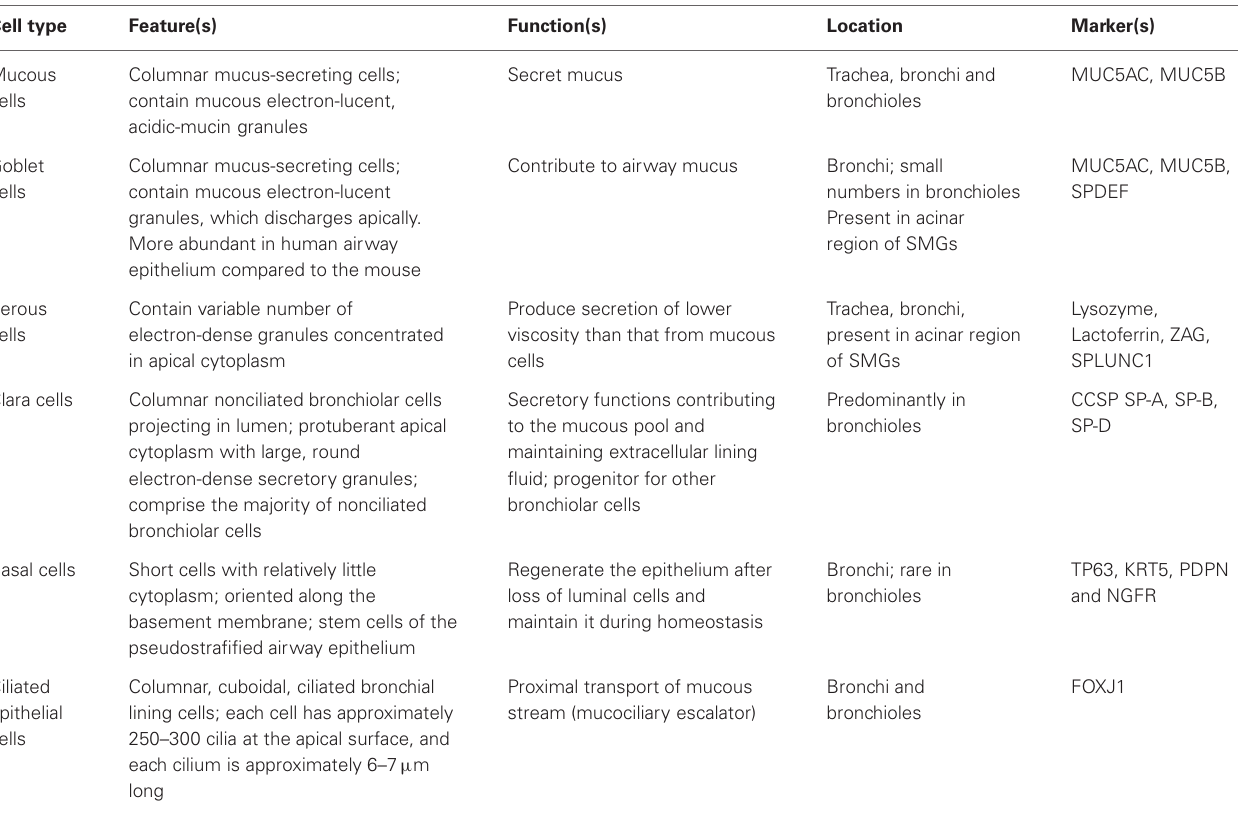
Table 1 | Major cell types of respiratory tract